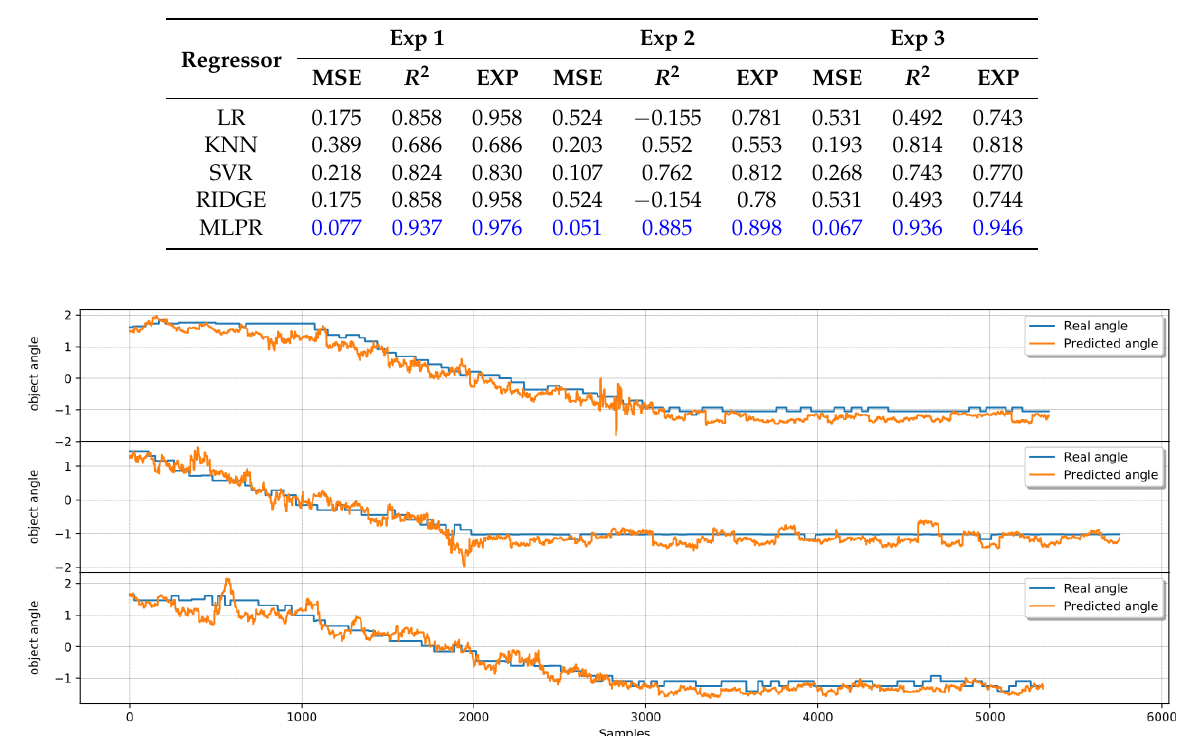
Table 4. Self-rotation angle estimation with blue indicating best results.